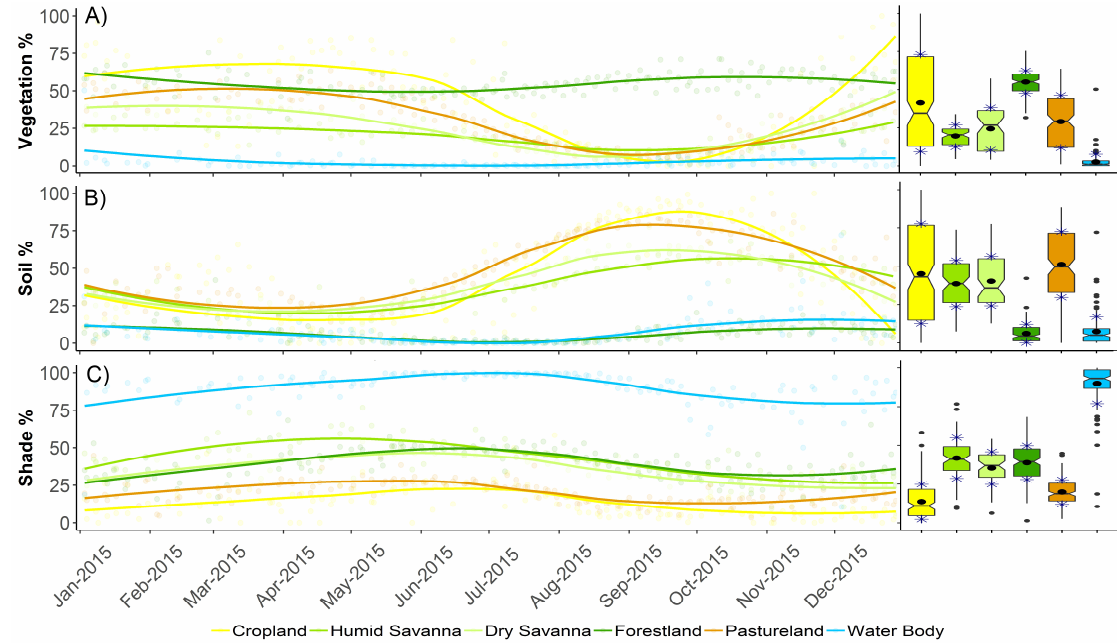
Figure 4. Annual time series of the linear spectral mixture model (LSMM) fraction images of vegetation ( A ), soil ( B ), and shade ( C ) of six representative land use and land cover classes of Mato Grosso state derived from the PROBA-V 100-m datasets. Figures on the right side are the boxplots of annual fraction images of croplands, humid savanna, dry savanna, forestland, pastureland, and water bodies. Filled dots and asterisks represent the mean and the standard deviation, respectively.